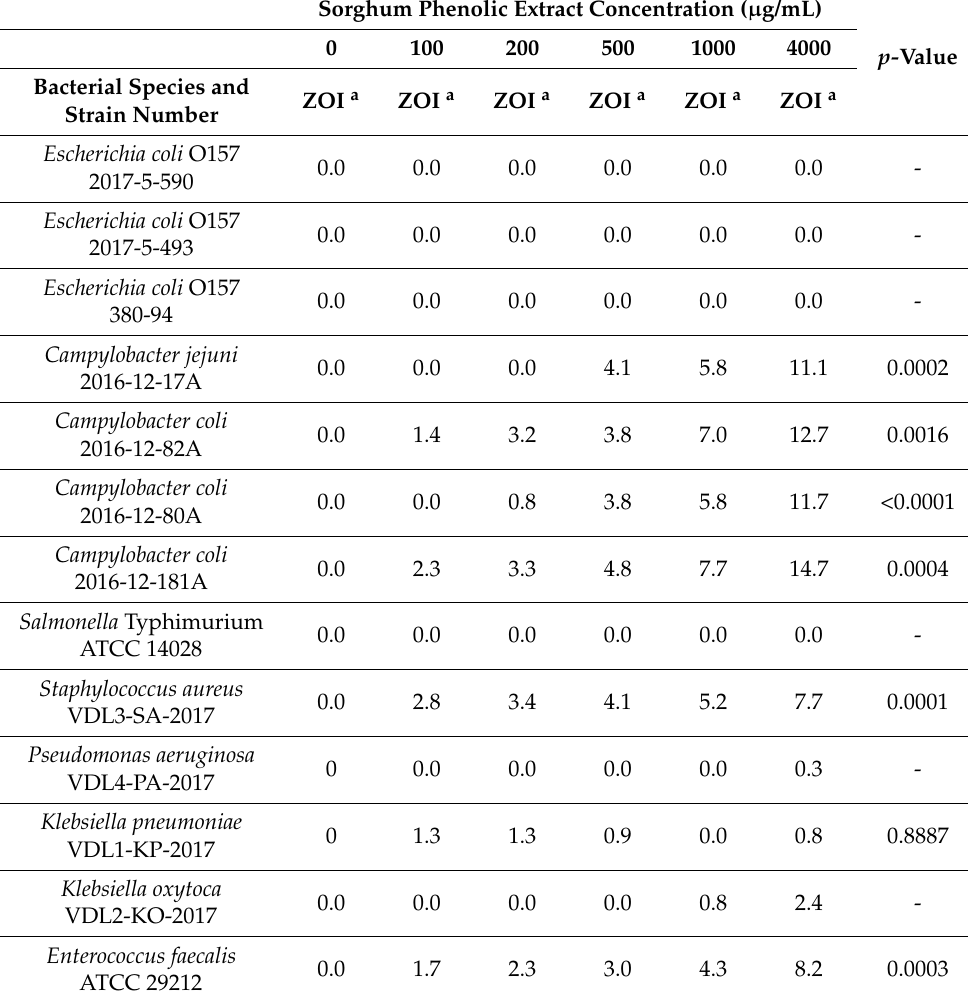
Table 1. Overall antimicrobial effects of sorghum phenolic extract. Sorghum Phenolic Extract Concentration ( µ